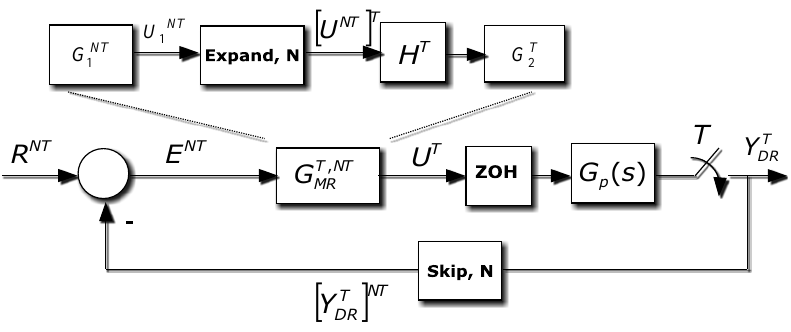
Figure 4. Dual rate controller